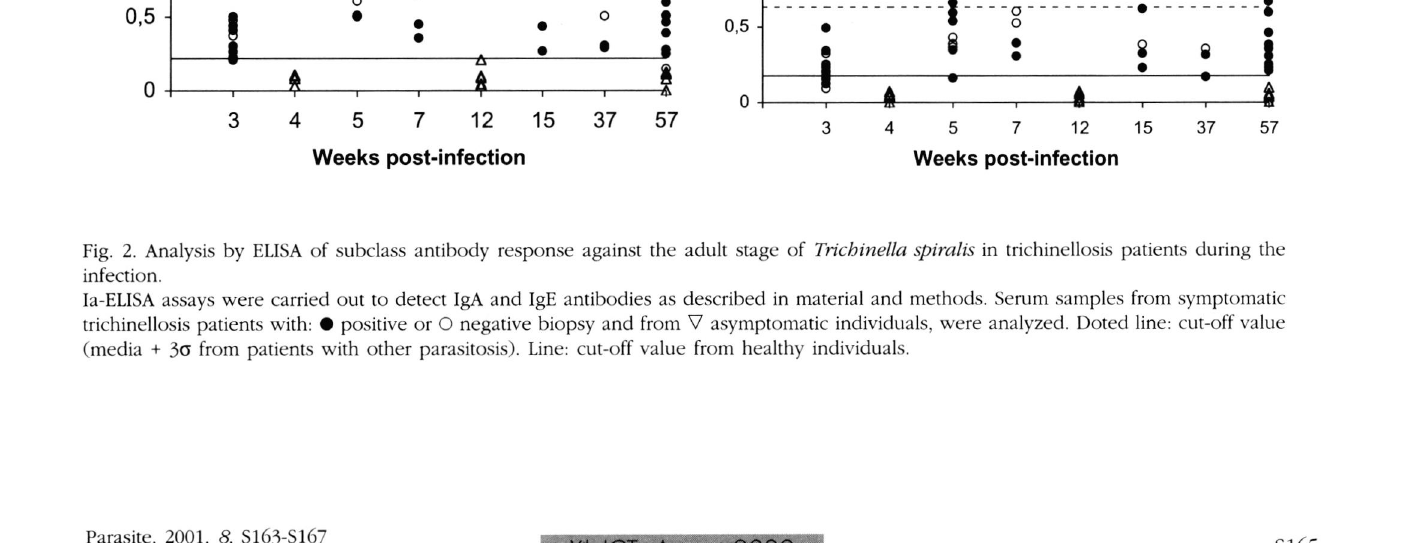
Parasite, 2001, 8, S163-S167